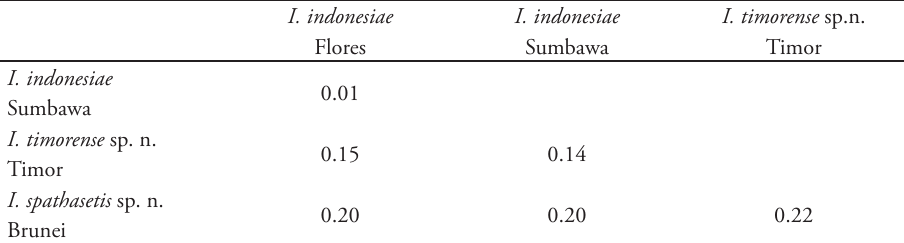
Table 3. Genetic distances (COI) between some Indocloeon species, using the Kimura